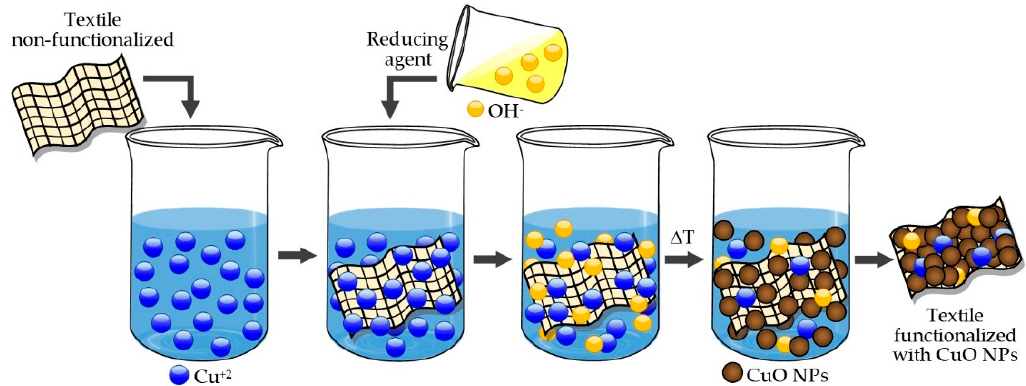
Figure 1. Scheme of textile functionalization by the in situ method.